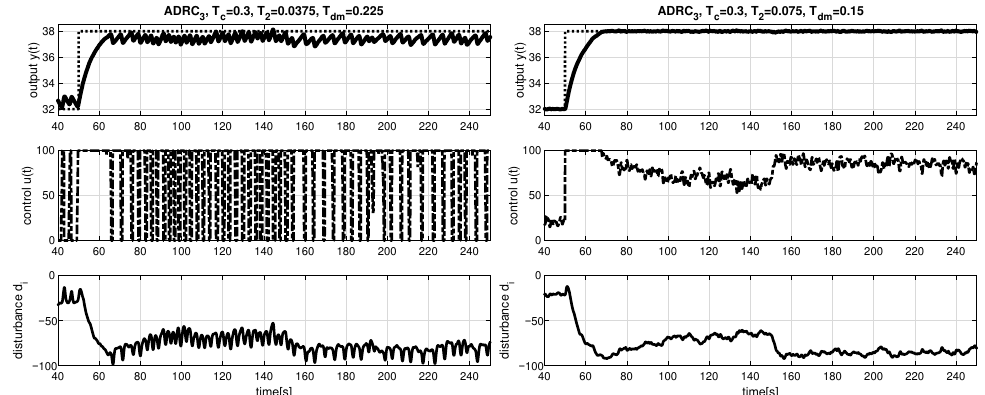
Figure 9. ADRC 3 : impact of T 2 = T d /8 ( left ) and T 2 = T d /4 ( right ) for a relatively slow disturbance observer with T c = T d , T dm = T d = T d − 2 T 2 .